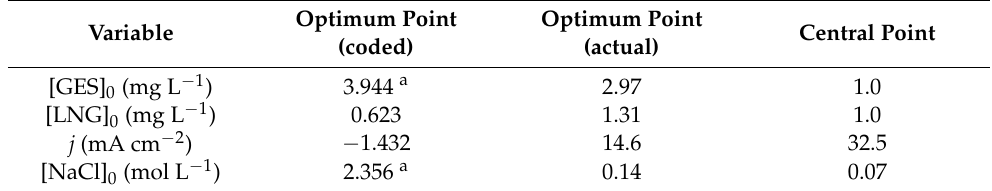
Table 7. Values obtained as the optimum point, coded and actual, and central point.